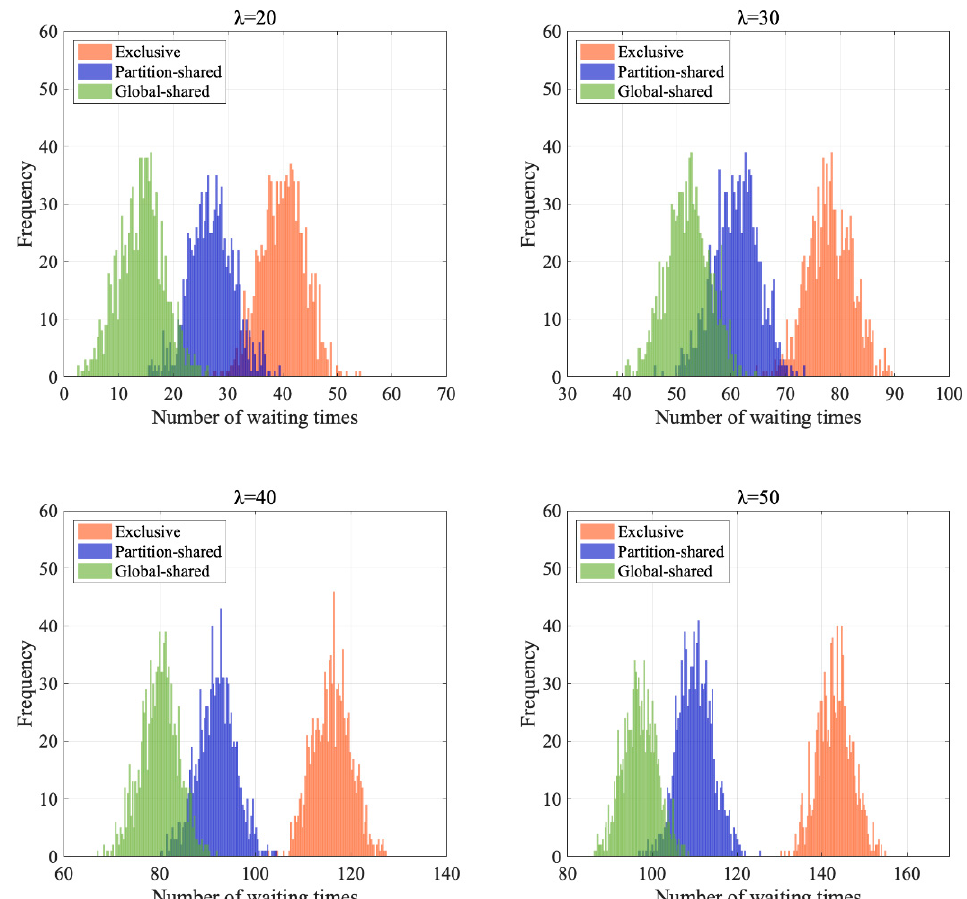
Figure 13. The Frequency Distributions of the Simulation Experiments in terms of Number of Waiting Times.